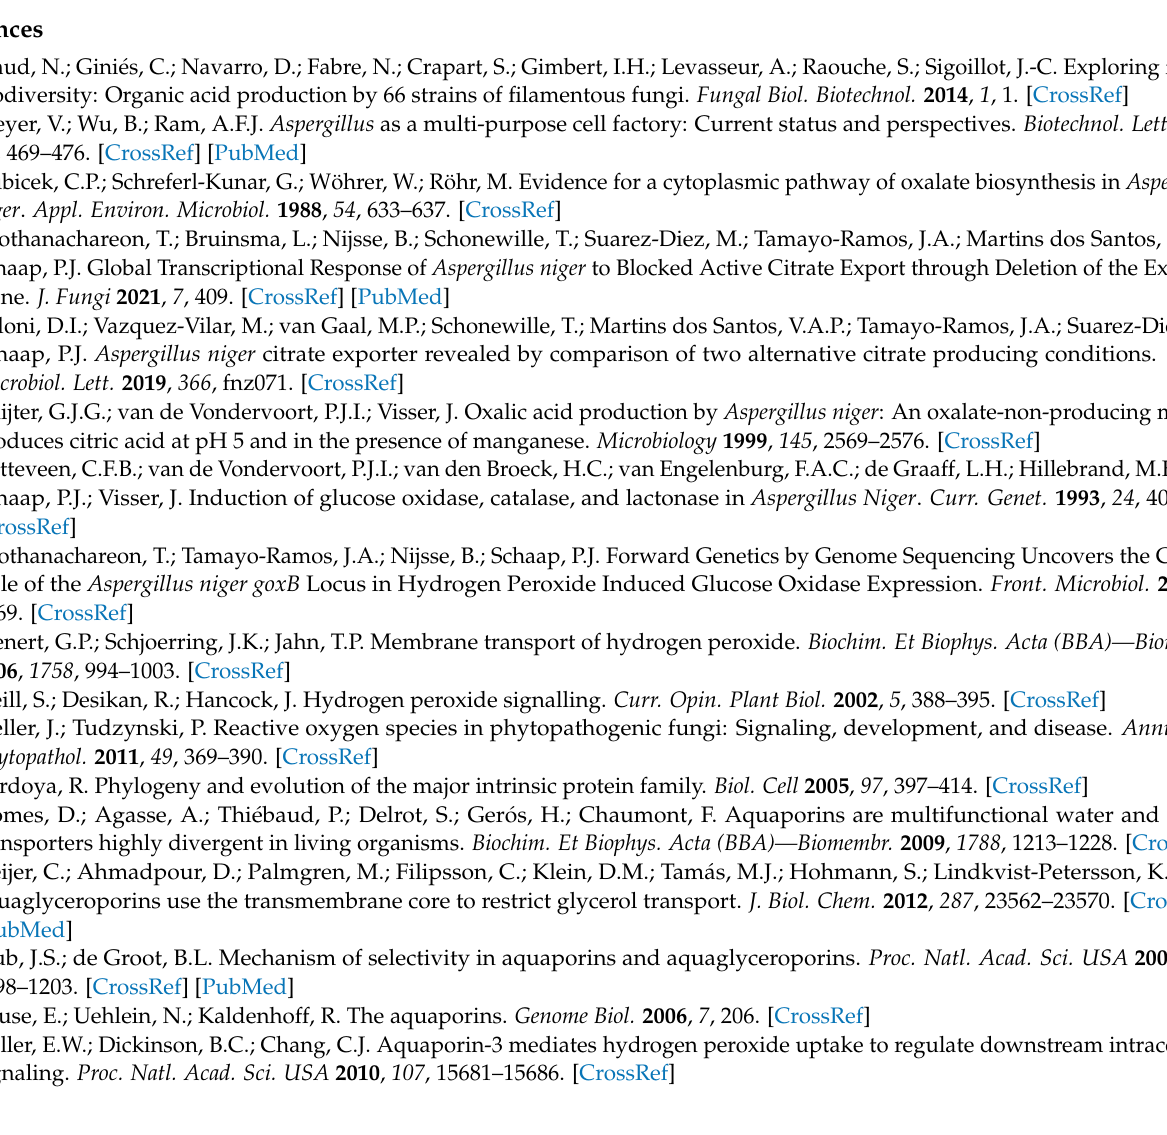
Table S1: Primers used in this study. Dataset S1: A. niger AQPs sequences and domain